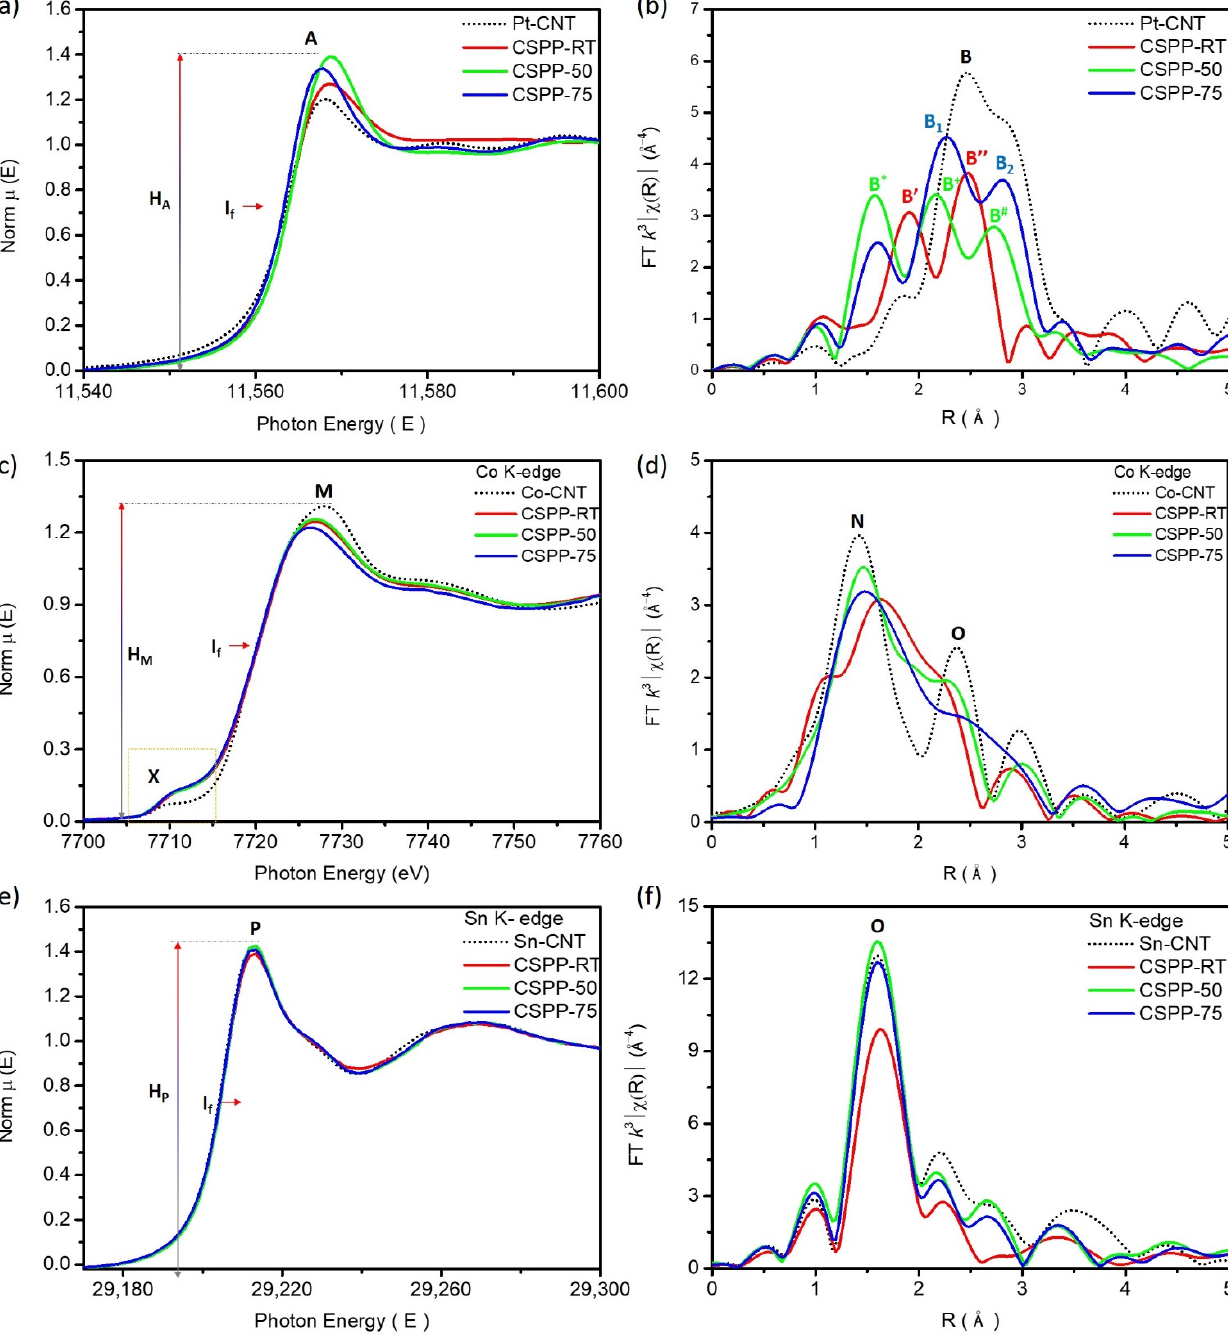
Figure 3. X-ray absorption spectroscopy of CSPP NCs and reference samples. ( a ) XANES and ( b ) FT- EXAFS spectra of CSPP NCs at Pt L 3 -edge, compared Pt-CNT. ( c ) XANES and ( d ) FT-EXAFS spectra of CSPP NCs at Co K-edge, compared with Co-CNT. ( e ) XANES and ( f ) FT-EXAFS spectra of CSPP NCs at Sn K-edge, compared with